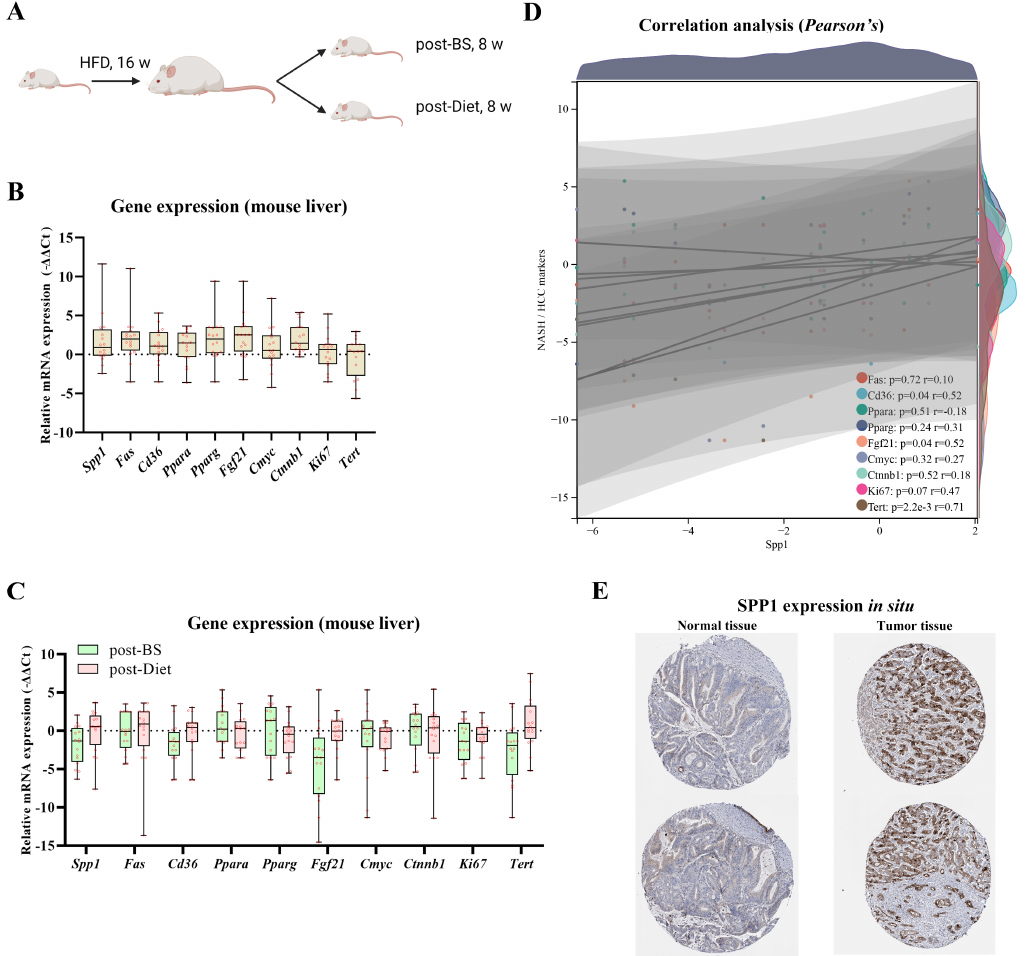
Figure 6. SPP1 expression in mouse models and patients. ( A ) Post ‐ BS and ‐ Diet on obese mouse models were performed. Relative gene expressions of Spp1 and 9 NASH/HCC biomarkers ( Fas , Cd36 , Ppara , Pparg , Fgf21 , Cmyc , Ctnnb1 , Ki67, and Tert ) were displayed in obese ( B ), Post ‐ BS, and ‐ Diet mouse livers ( C ). ( D ) Correlation analyses between Spp1 and 9 NASH/HCC biomarkers ( Fas , Cd36 , Ppara , Pparg , Fgf21 , Cmyc , Ctnnb1 , Ki67, and Tert ) were respectively conducted following the Pearson’s method. ( E ) SPP1 expressions in situ (normal tissue vs. tumor tissue) were generated from the HPA database.